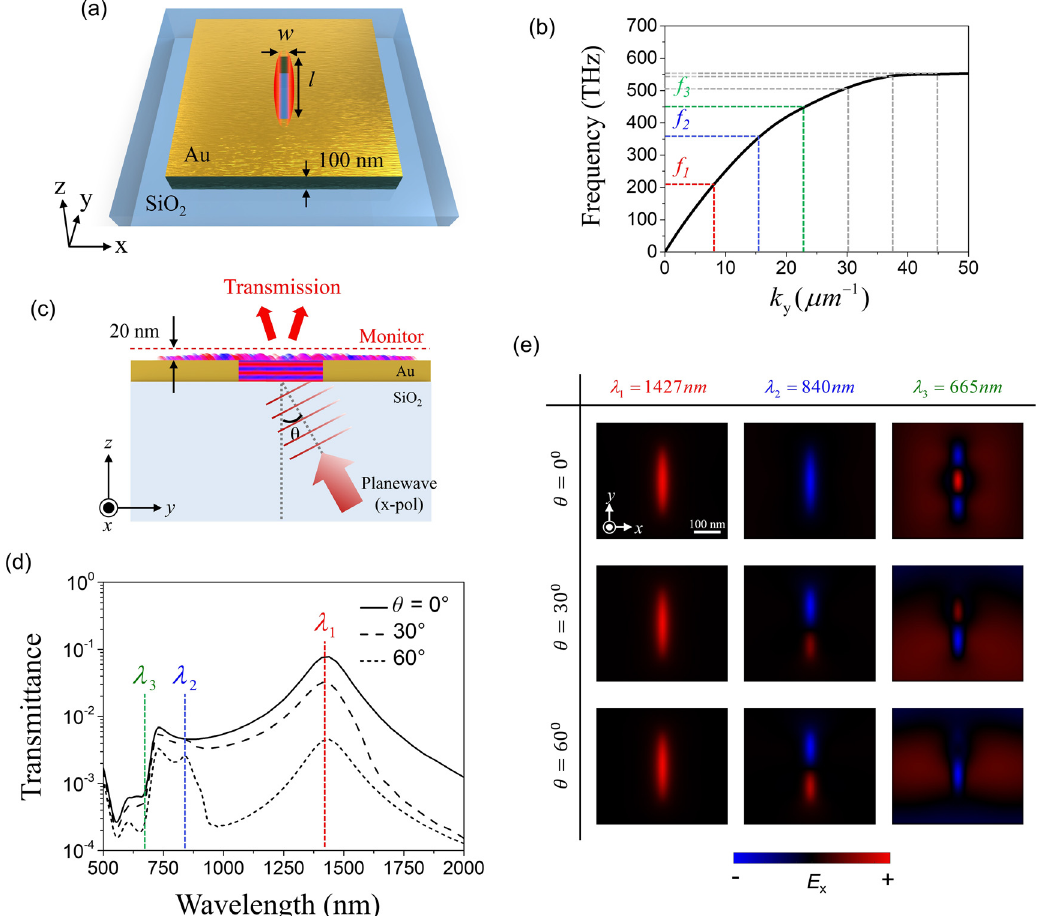
Figure 2: Transmission spectrum-based mode analysis for single-slot nanoantenna. (a) Schematic of single-slot nanoantenna with a width ( w ) of 20 nm and length ( l ) of 300 nm. (b) Dispersion relation of gold – air – gold waveguide mode propagating along y -direction. Red, blue, and green dashed lines indicate 1st, 2nd, and 3rd resonant modes, respectively. (c) Schematic of single-channel measurement simulation condition of a single-slot nanoantenna by changing the incident angle ( θ ). (d) Transmittance spectrum of a single-slot nanoantenna by adjusting incident angle. Solid, dashed, and dotted curves indicate transmitted spectra for the incident angles of 0, 30, and 60 ° , respectively. Red, blue, and green dashed lines indicate the 1st, 2nd, and 3rd modes, respectively.(e)Real E x fi eldpro fi lesofsingle-slotnanoantennafor0,30,and60degreesofincidentangleat1st(1427nm),2nd(840nm),and 3rd (665 nm)